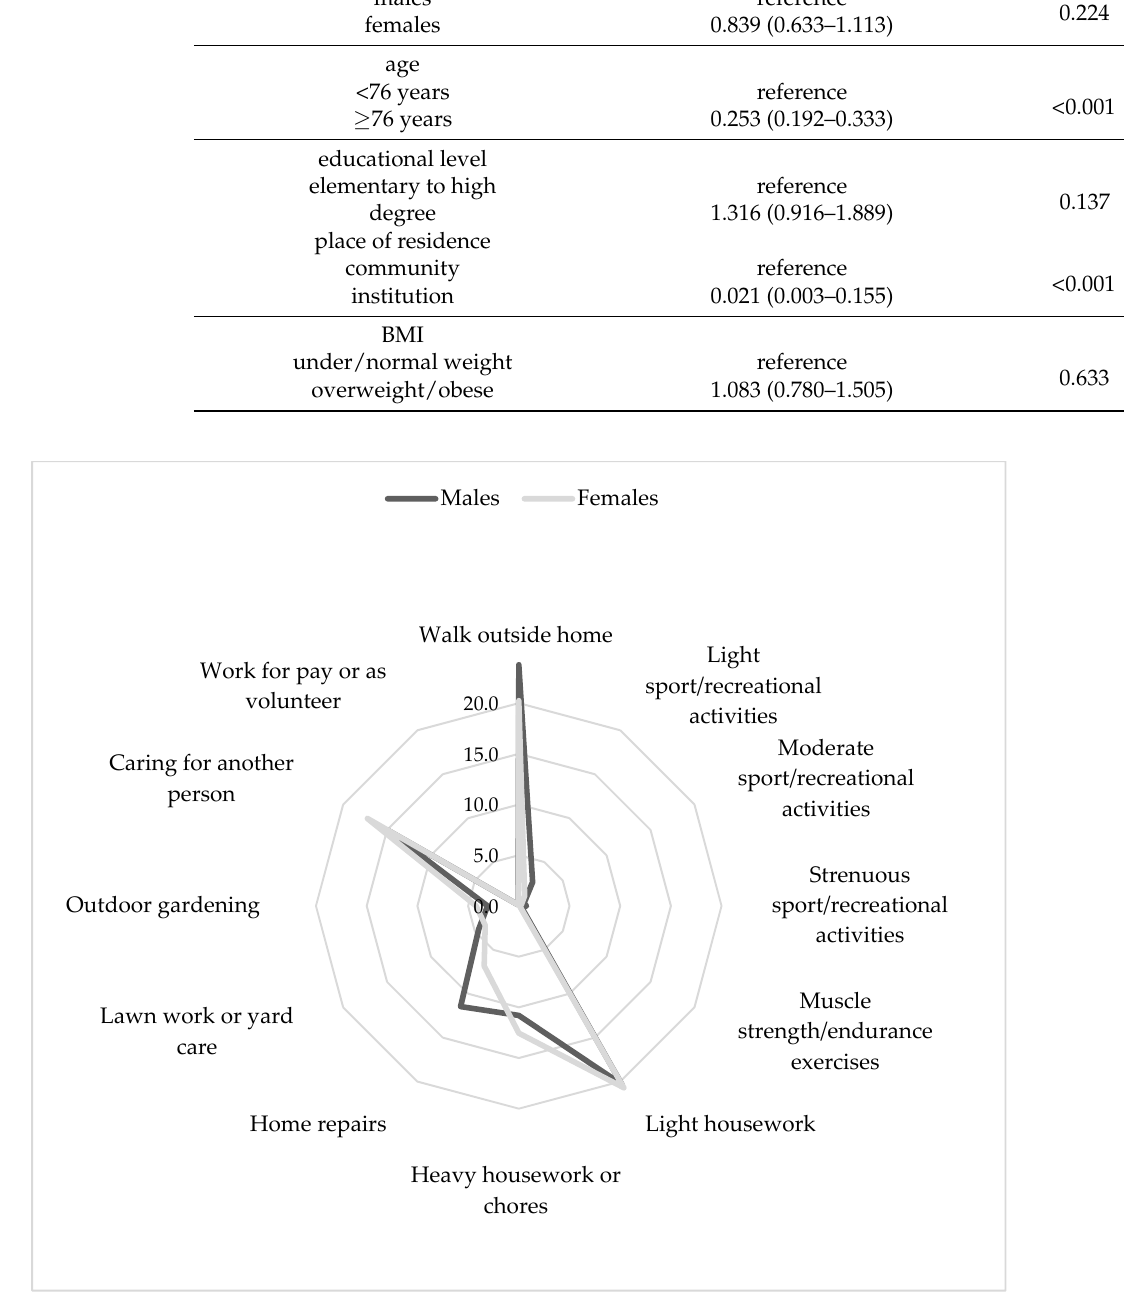
Figure 1. Types of physical activities reported by male and female participants.